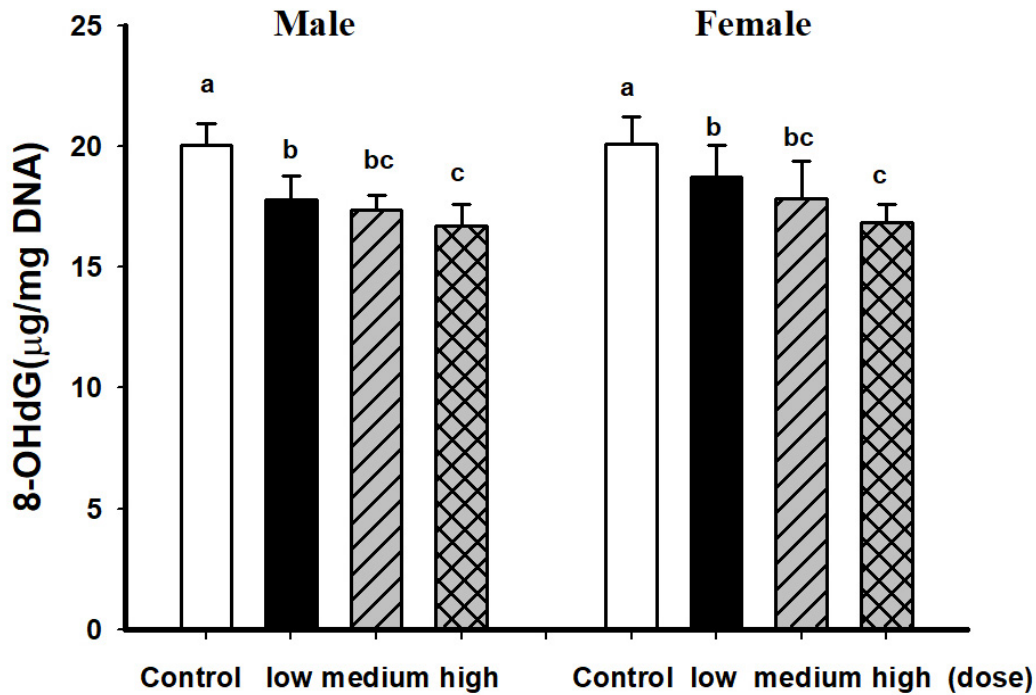
Figure 8. 8-OHdG levels of mice brain after 13 weeks feeding. Low dose group (108 mg/kg/bw/day), intermediate dose group (215 mg/kg/bw/day), high dose group (431 mg/kg/bw/day). Values are expressed as mean ± S.E.M. and analyzed by one-way ANOVA ( n = 10). Groups with different letters denote significant difference between each group ( p < 0.05).